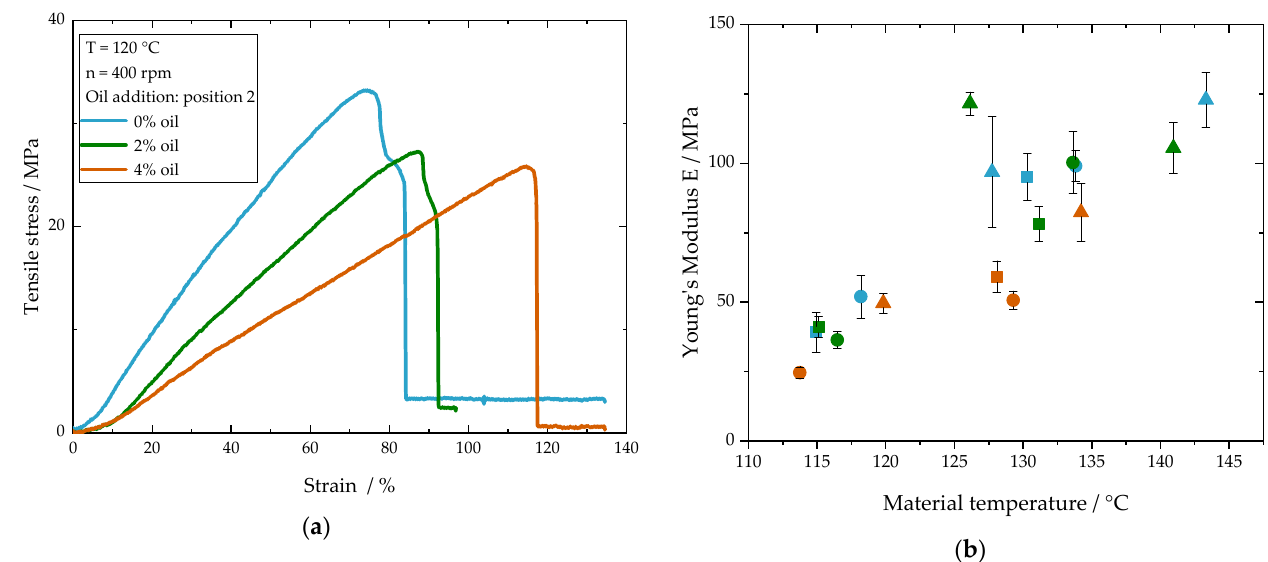
Figure 8. ( a ) Stress–strain-diagrams for samples with 0%, 2% and 4% oil. ( b ) Young’s modulus as a function of the material temperature for samples with 0% oil (blue), 2% oil (green) and 4% oil (orange) extruded with 200 rpm ( (cid:4) ), 400 rpm ( • ) and 800 rpm ( ▲ ) at different barrel temperatures (120 and 140 °C). Oil was added at position 2. Total mass flow was 10 kg/h and water content was 51–53% for all samples.